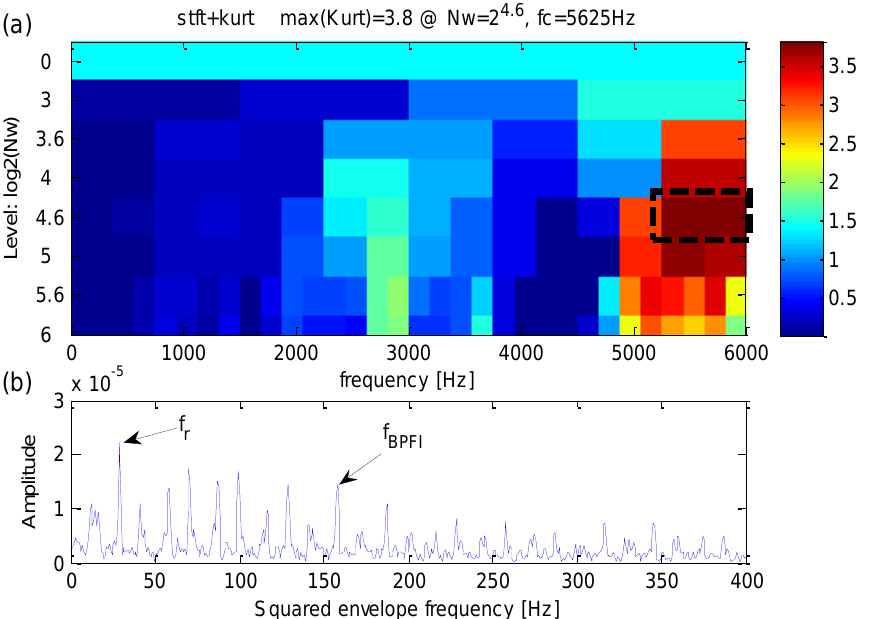
Figure 13. ( a ) The kurtogram of data X171_FE; ( b ) the squared envelope spectrum of the frequency band with the maximum kurtosis.